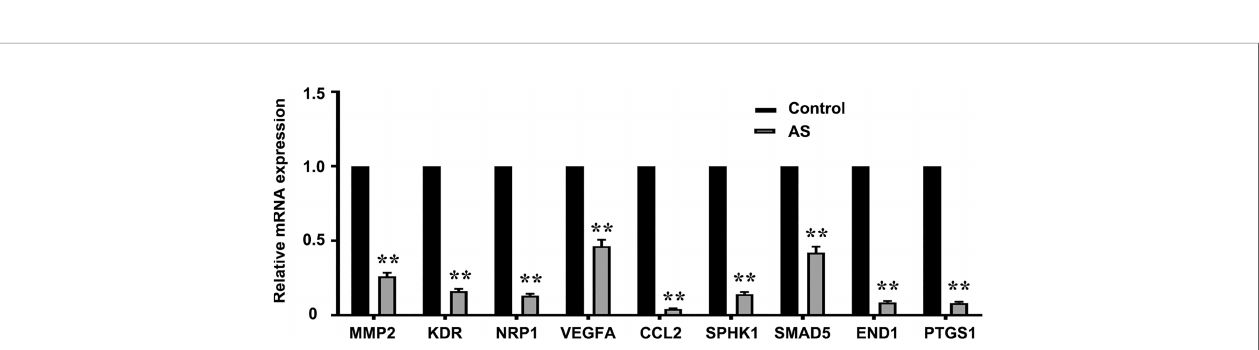
FIGURE 2 | AS treatment reduces pro-angiogenesis gene expression. Pro-angiogenesis genes were detected by PCR in HUVECs treated with an inhibitor of STAT6 (1 m M) for 24 h. ** P <0.01 vs. control. MMP2, matrix metalloproteinase-2; KDR, kinase insert domain-containing receptor; NRP1, neuropilin-1; VEGFA, vascular endothelial growth factor A; CCL2/MCP-1, monocyte chemoattractant protein-1; SPHK1, sphingosine kinase 1; SMAD5, mothers against DPP homolog 5; EDN1, endothelin-1; PTGS1/COX1, cyclooxygenase 1.